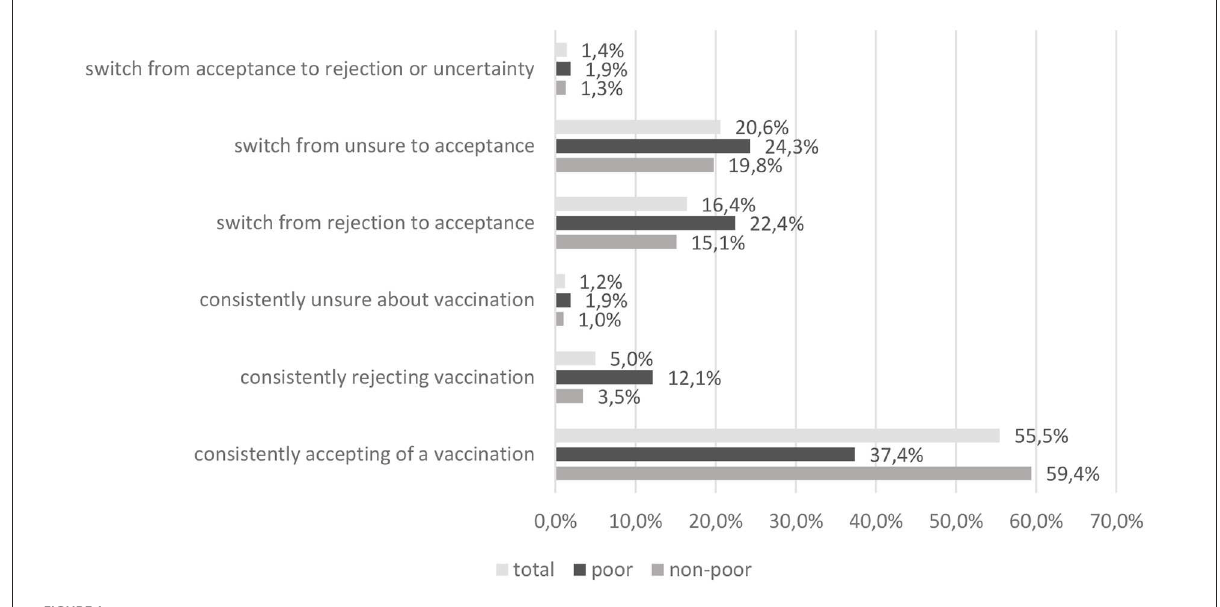
FIGURE1 Attitude change toward